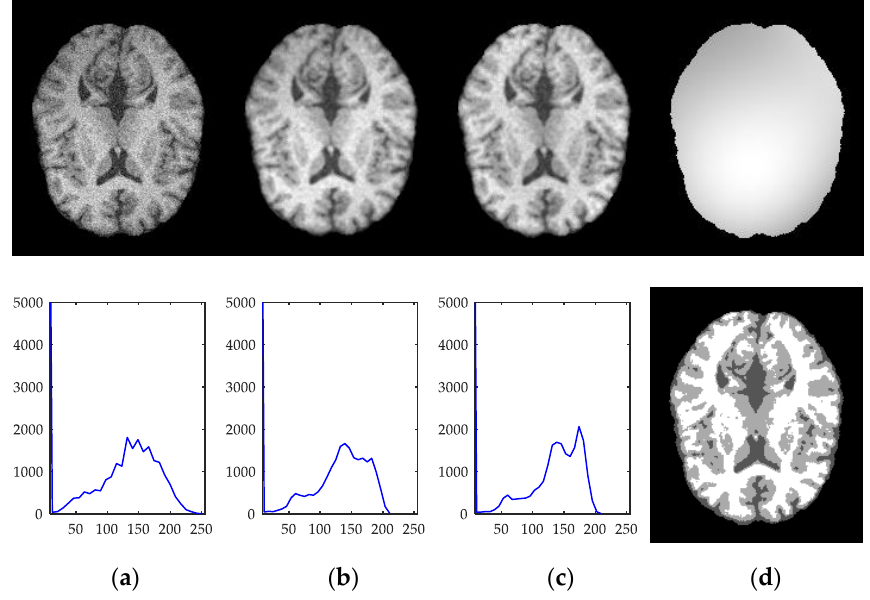
Figure 1. The composition of the robust clustering with local contextual information (RC_LCI) model: ( a ) original image and corresponding histogram; ( b ) noise-removed image and corresponding histogram; ( c ) bias field correction image and corresponding histogram; and ( d ) estimated bias field and segmentation result.